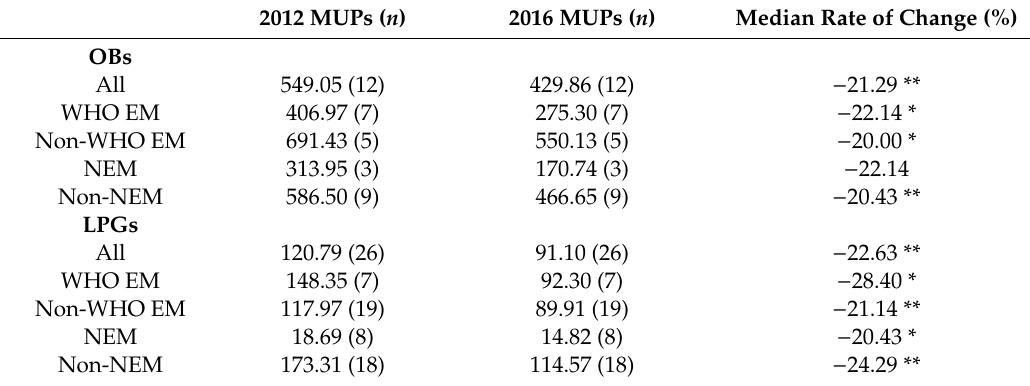
Table 6. Median unit prices of anticancer medicines and the median rate of price changes in 2012 and 2016.